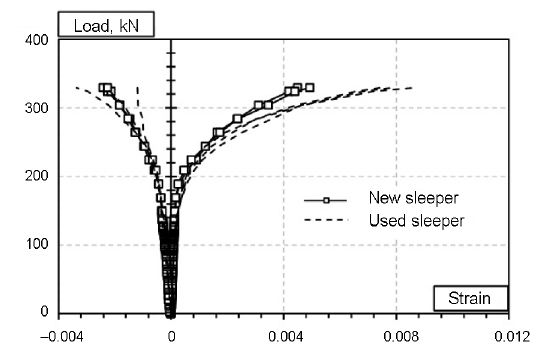
Fig. 8. Load-strain relationships under dynamic